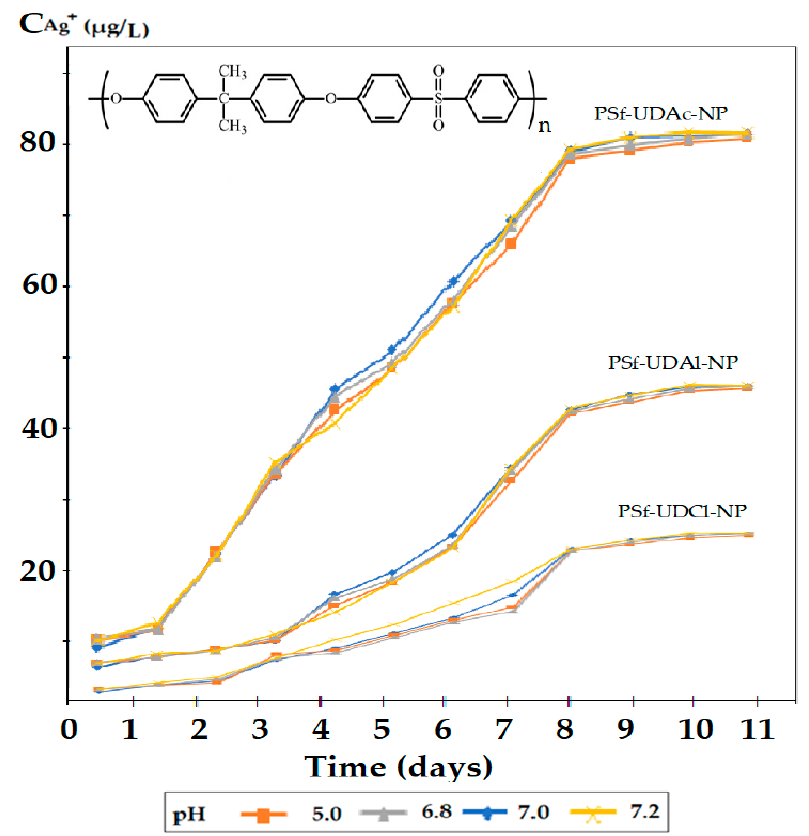
Figure 7. Concentration of silver ions released in the receiving aqueous phase of pH: 5.0, 6.8, 7.0 and 7.2 for polysulfone membrane in the case of 10–undecenoic acid (UDAc), 10–undecen–1–ol (UDAl) or 10–undecenoic chloride (UDACl) as dispersants and oxide nanoparticles with 1.63% silver.